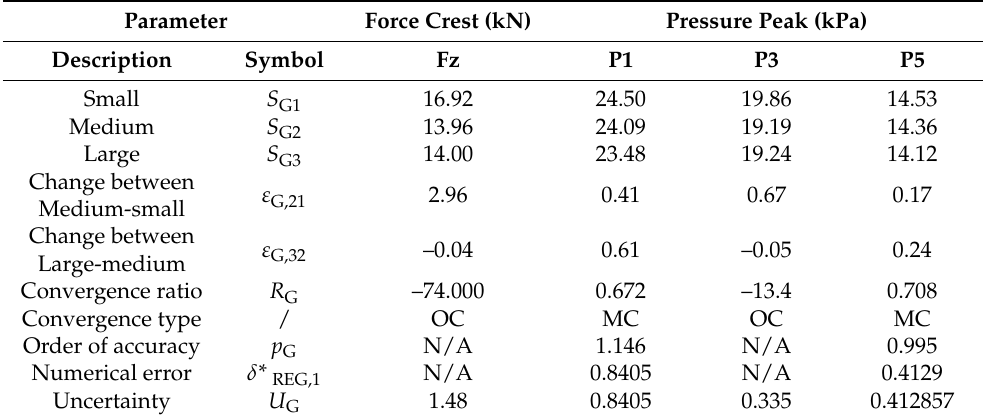
Figure 14. Comparison of time series of slamming results by different time-step schemes: ( a ) vertical total force; ( b ) pressure at P1; ( c ) pressure at P3; ( d ) pressure at P5. Table 7. Convergence study for slamming results using different time-step schemes.